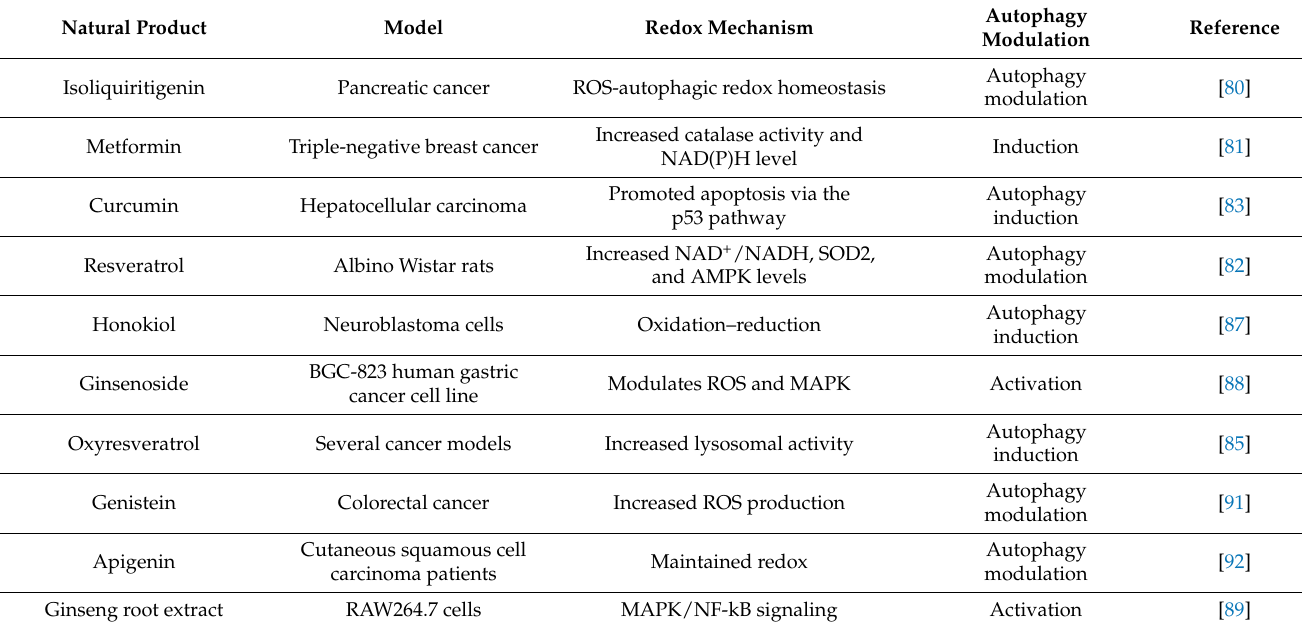
Table 2. Recent use of natural compounds to maintain redox equilibrium in autophagy-mediated signaling in various cancer cells.